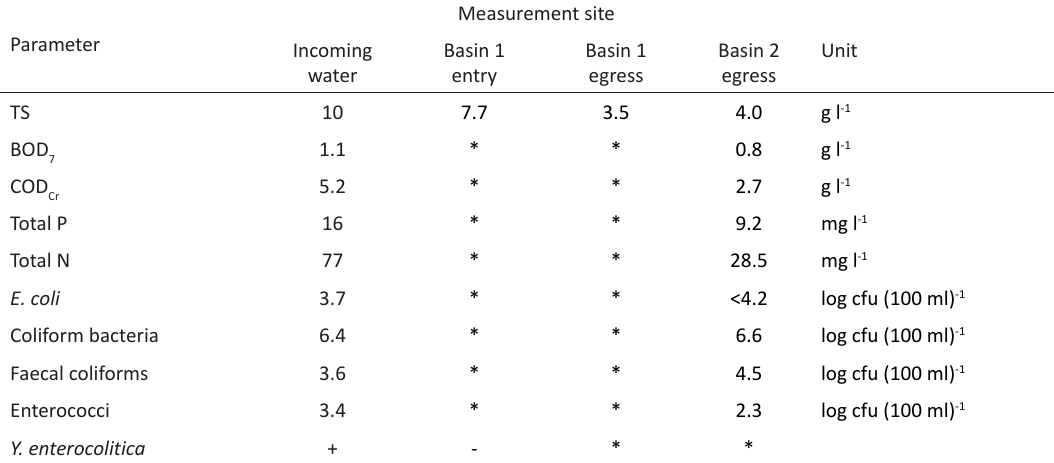
Table 4. The quality of wastewater basins of carrot washing water (plant A). Volumes of the two basins were 110 m 3 and 90 m 3 .